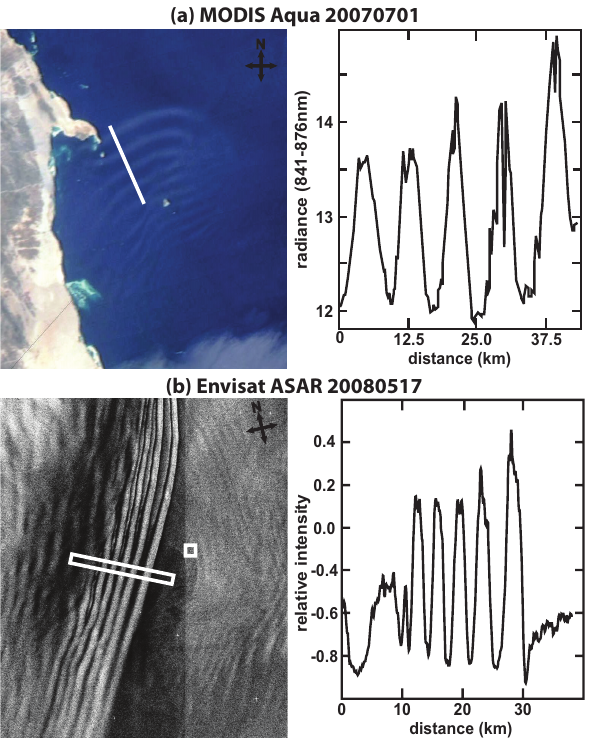
Fig. 3. Close-ups (subsets) for two case studies together with tran- sect profiles represented by the white lines: (a) MODIS-Aqua im- age dated 1 July 2007 acquired at 10:20UTC; (b) Envisat-ASAR image dated 17 May 2008 acquired at 07:22UTC.